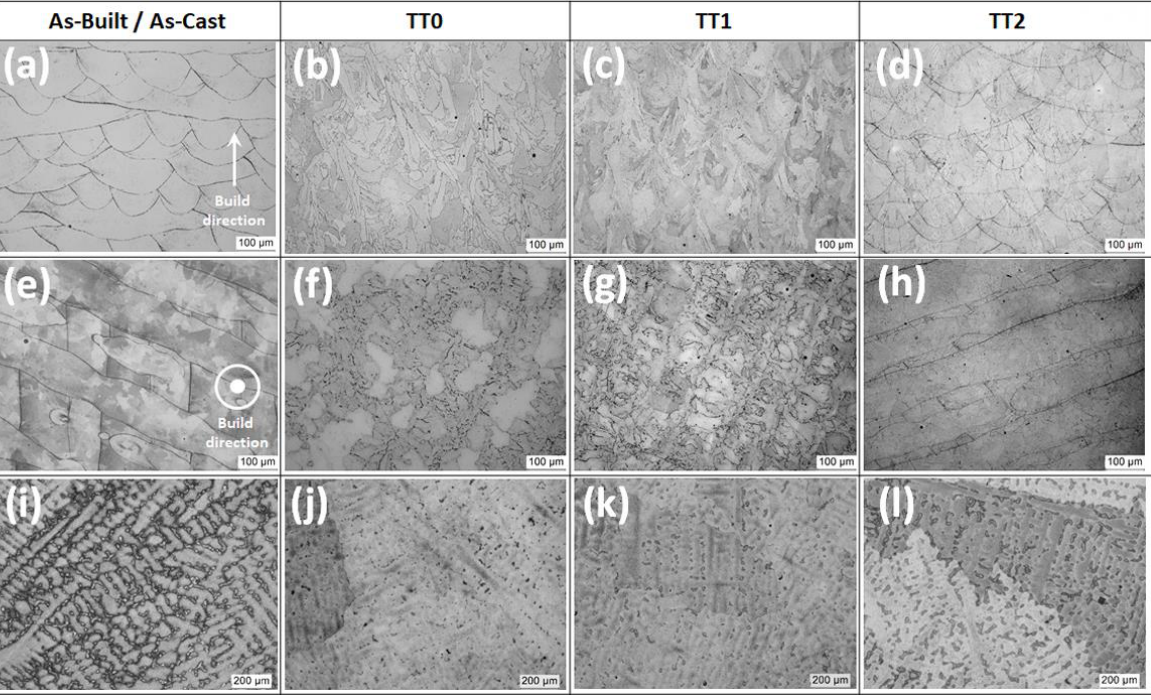
Figure 8. Optical micrographs for IN718 in as-built/as-cast and heat-treated condition. ( a–d ): SLM samples in Y-axis, ( e–h ): SLM samples in Z-axis, and ( i–l ): Investment casting samples. (SLM samples are etched with Kalling Nº2 and investment casting samples only polished).